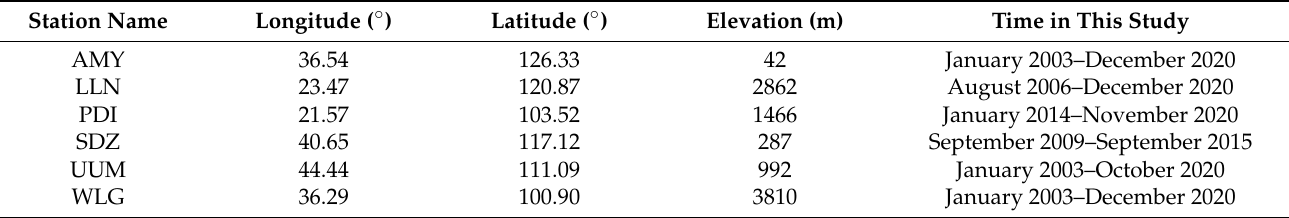
Table A1. Observed greenhouse gas information by WDCGG